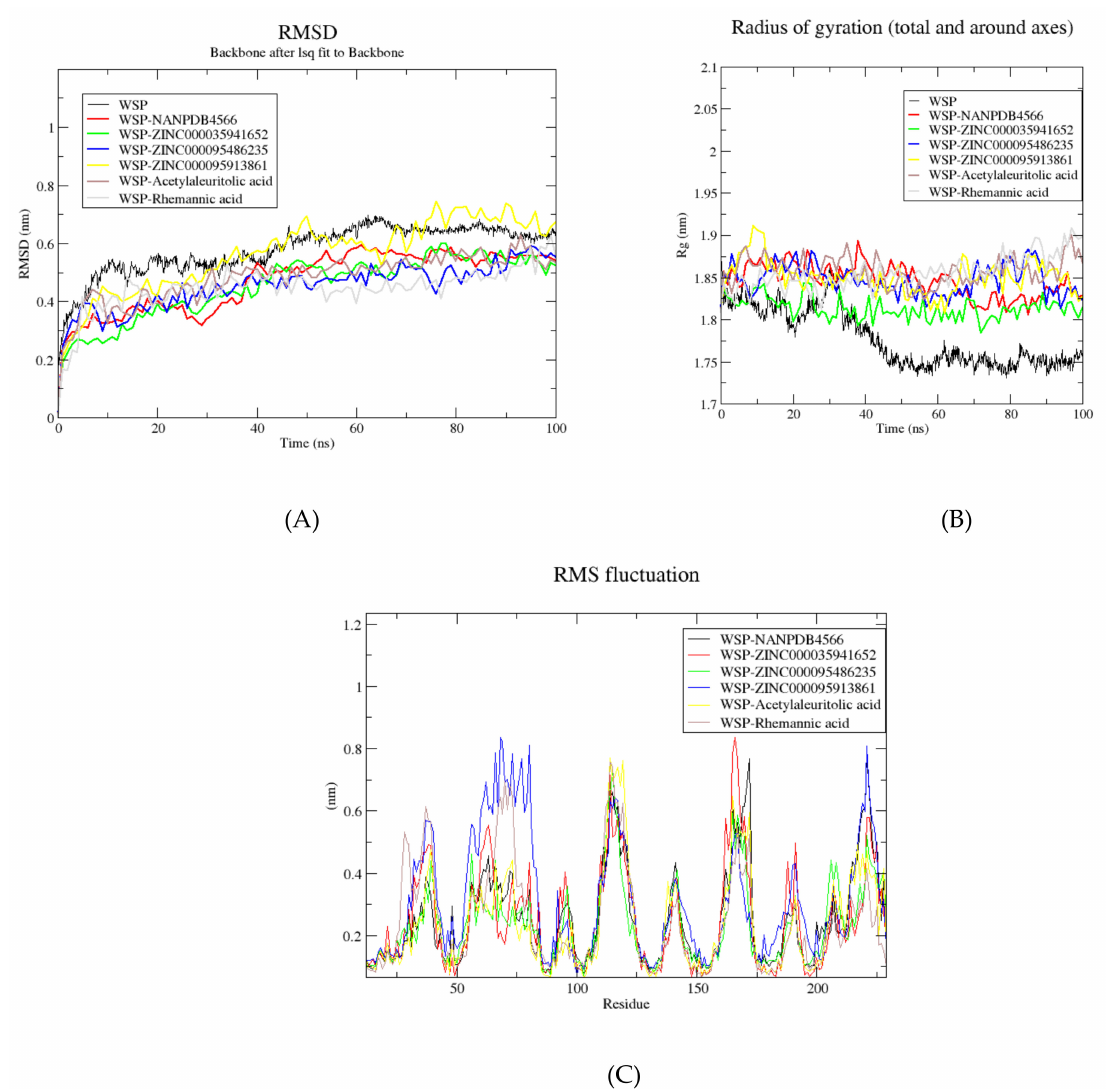
Figure 6. Root mean square deviation (RMSD), root mean square fluctuations (RMSF) and the radius of gyration (Rg) plots of 100 ns molecular dynamics (MD) simulations of the WSP-ligand complexes using GROMACS. ( A ) RMSD graph of the WSP-ligand complexes, ( B ) the Rg versus a time graph of the WSP-ligand complexes and ( C ) analysis of RMSF trajectories of residues of the WSP-ligand complexes. Legends with color codes are provided in each